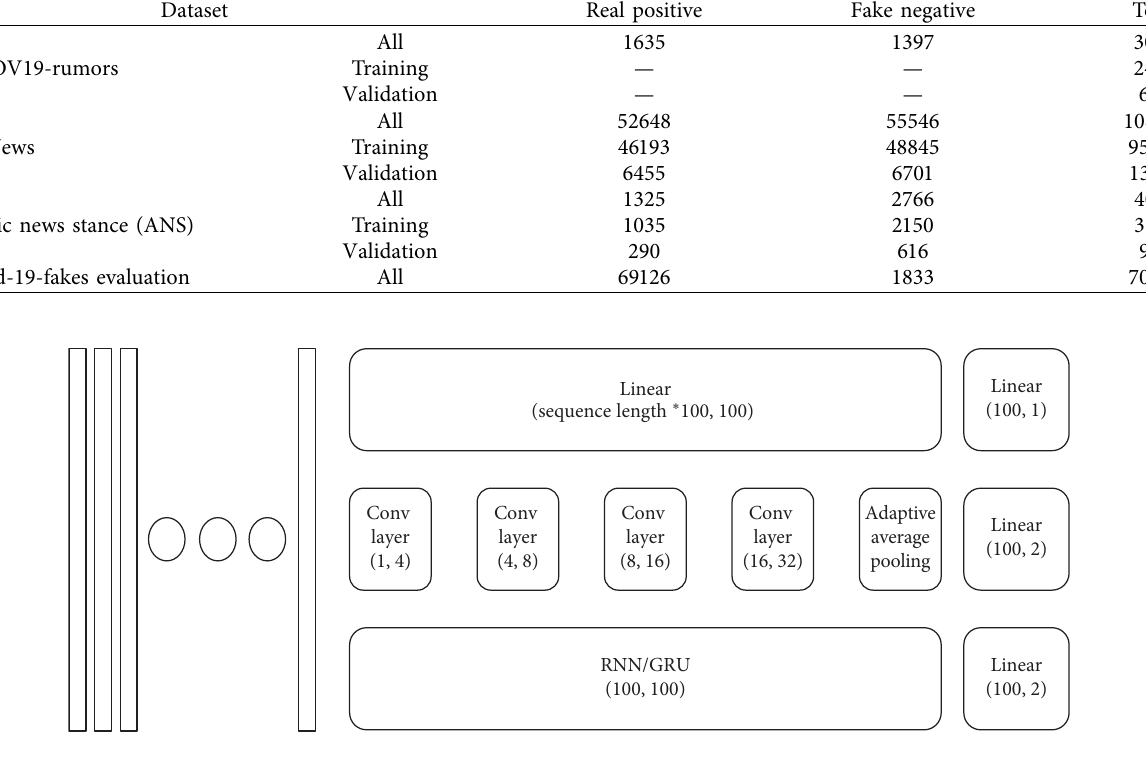
Figure 1: FND model